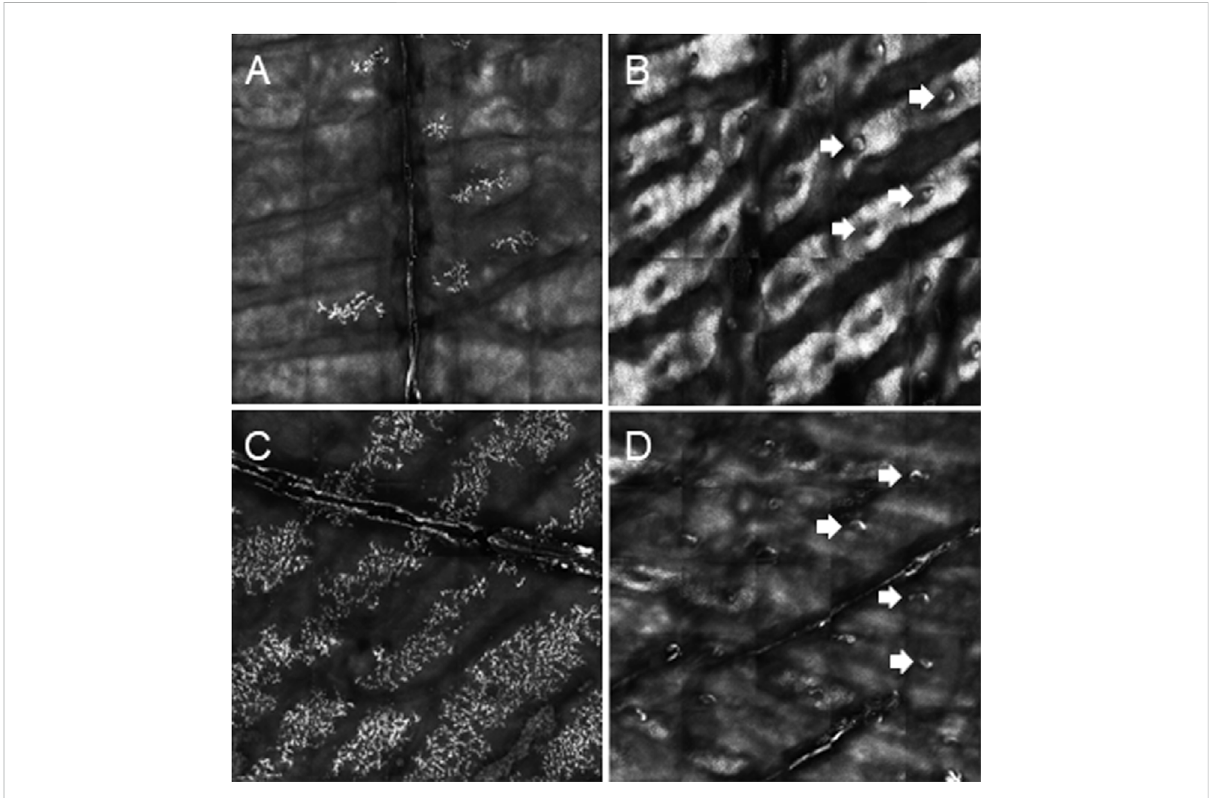
FIGURE 2 Determination of palmar sweat duct densities by confocal laser scanning microscopy (magni fi cation of a representative area of 6.25 mm 2 ). (A) Complete absence of sweat ducts in patient P1a. (B) Normal count and distribution of sweat ducts in his heterozygous sister P1b. (C) Lack of sweat ducts and distinct skin fi ssures in patient P3. (D) Reduced number of sweat pores in patient P4. White arrows indicate exemplarily some of the sweat pores.